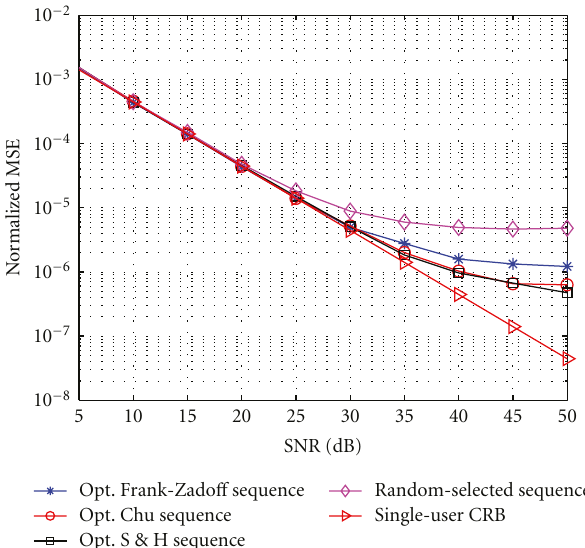
Figure 4: Comparison of CFO estimation using di ff erent N = 36 CAZAC sequences for L = 18 channel for uniform power delay profile.